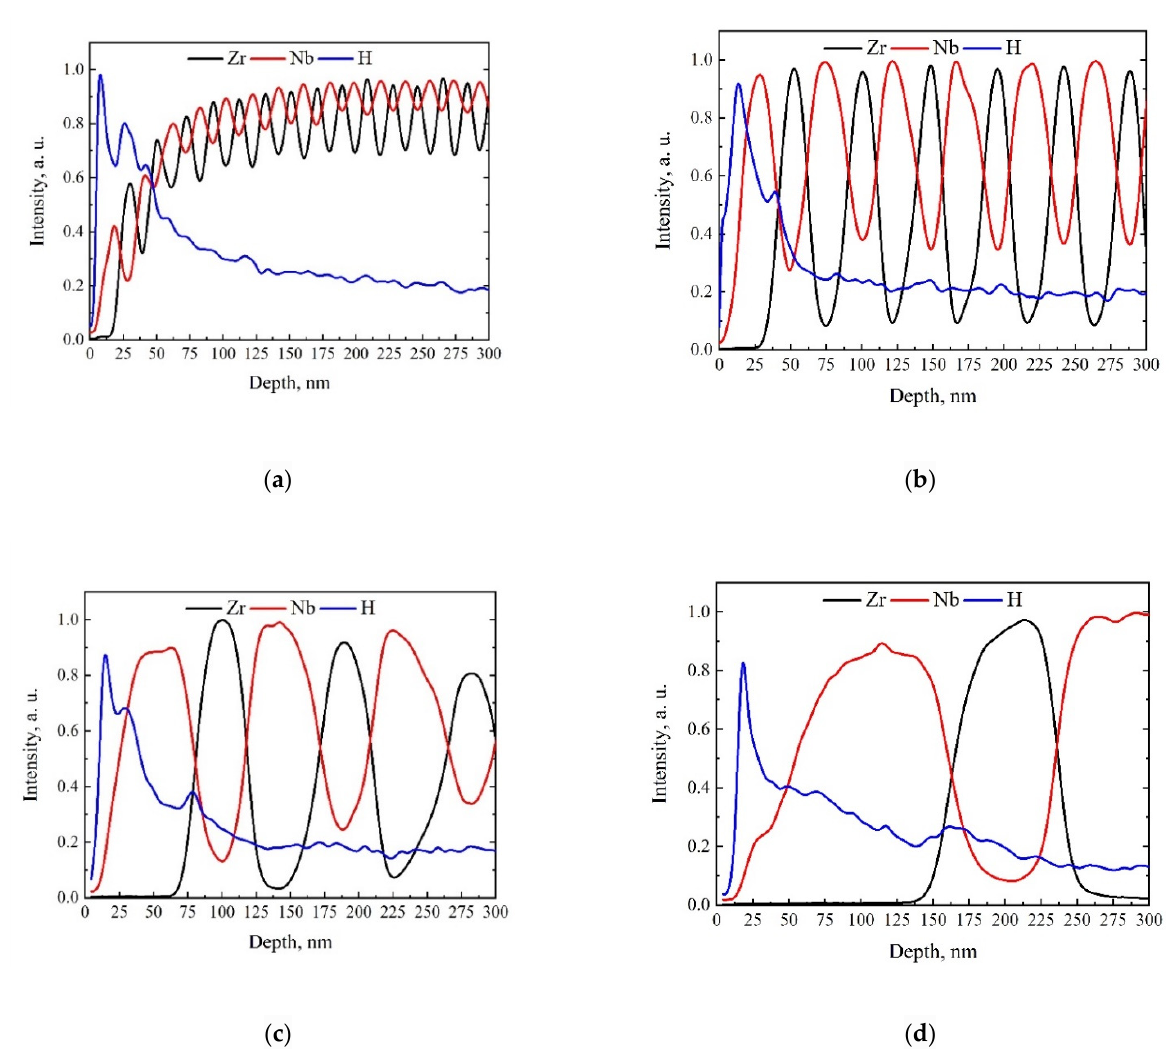
Figure 7. Depth distribution of elements for Zr/Nb NMCs after proton irradiation for: Zr/Nb 10 nm ( a ), Zr/Nb 25 nm ( b ), Zr/Nb 50 nm ( c ), and Zr/Nb 100 nm ( d ).